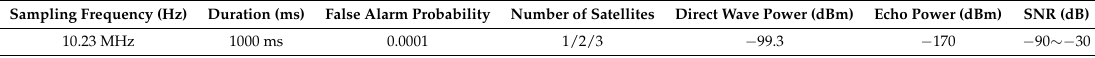
Table 5. Parameter setting of experiment